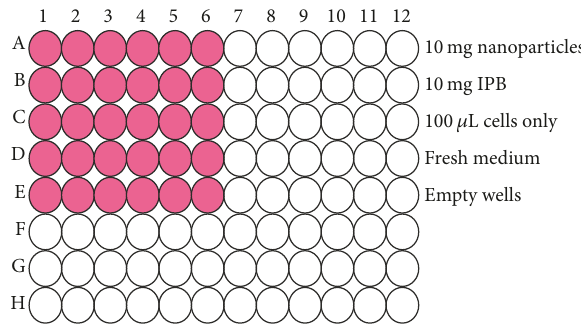
Figure 2: Schematic diagram of a 96-well plate depicting the arrangement of the samples, no-cell background and cells only.